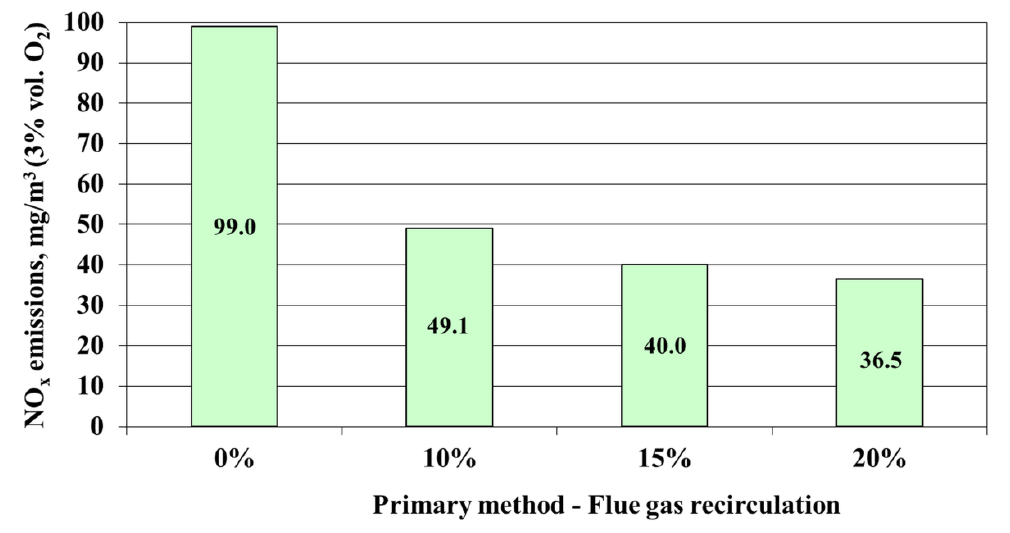
Figure 9. NO x emissions (expressed in mg / m 3 at 3% vol. oxygen in dry flue gas under normal temperature and pressure) dependence on flue-gas recirculation at burner power input 16 kW and air excess coefficient m = 1.1.